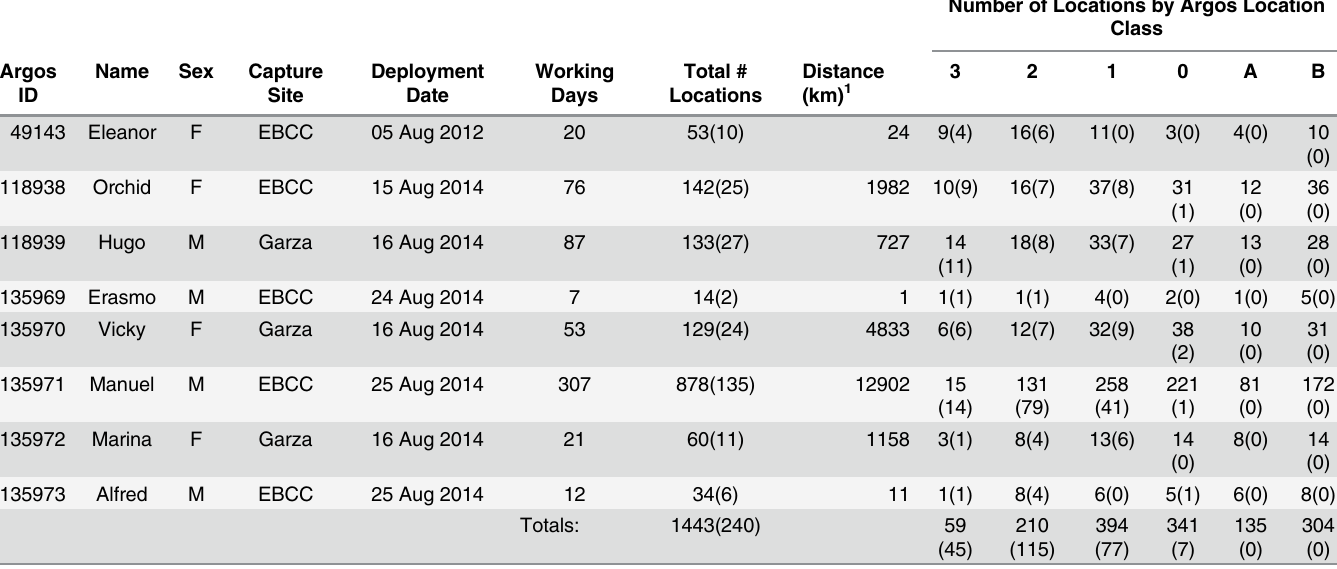
Table 1. Black Skimmer Argos ID ’ s, deployment statistics and location classes. Number of locations reported are for Full and (Filtered) datasets.